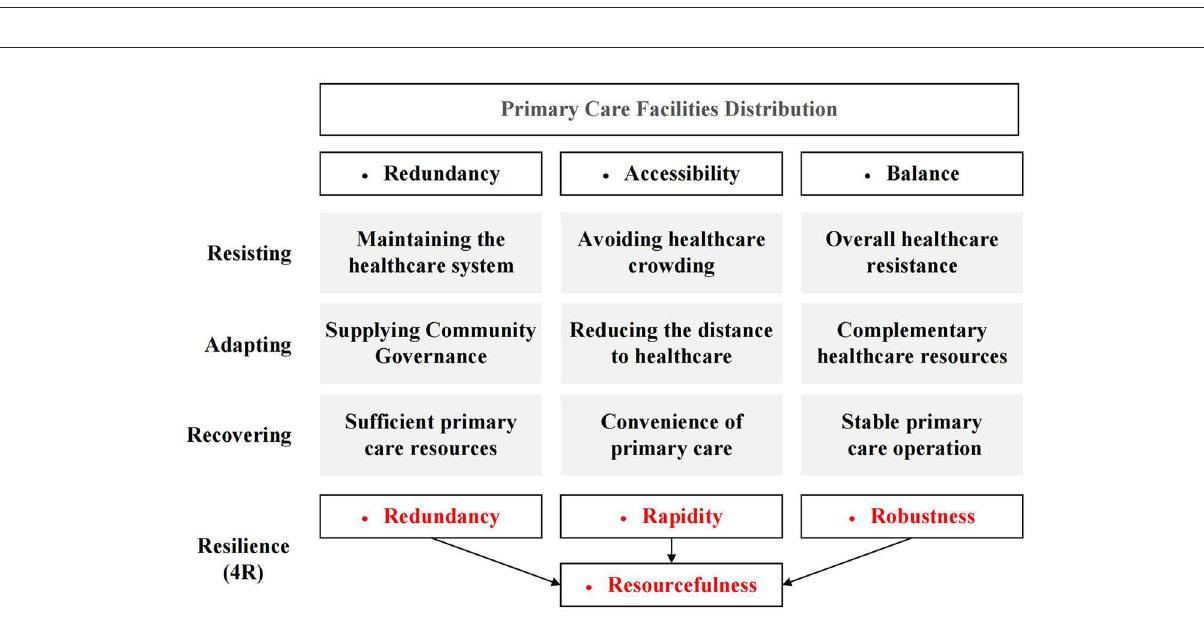
FIGURE3 Maximized coverage model operation